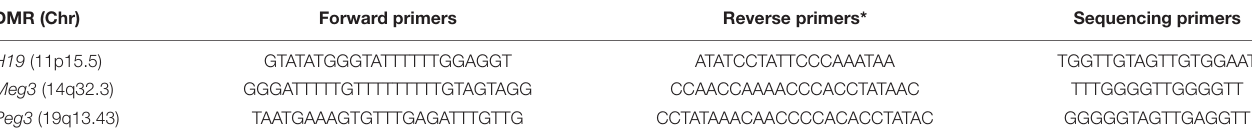
TABLE 1 | Primer sequences.